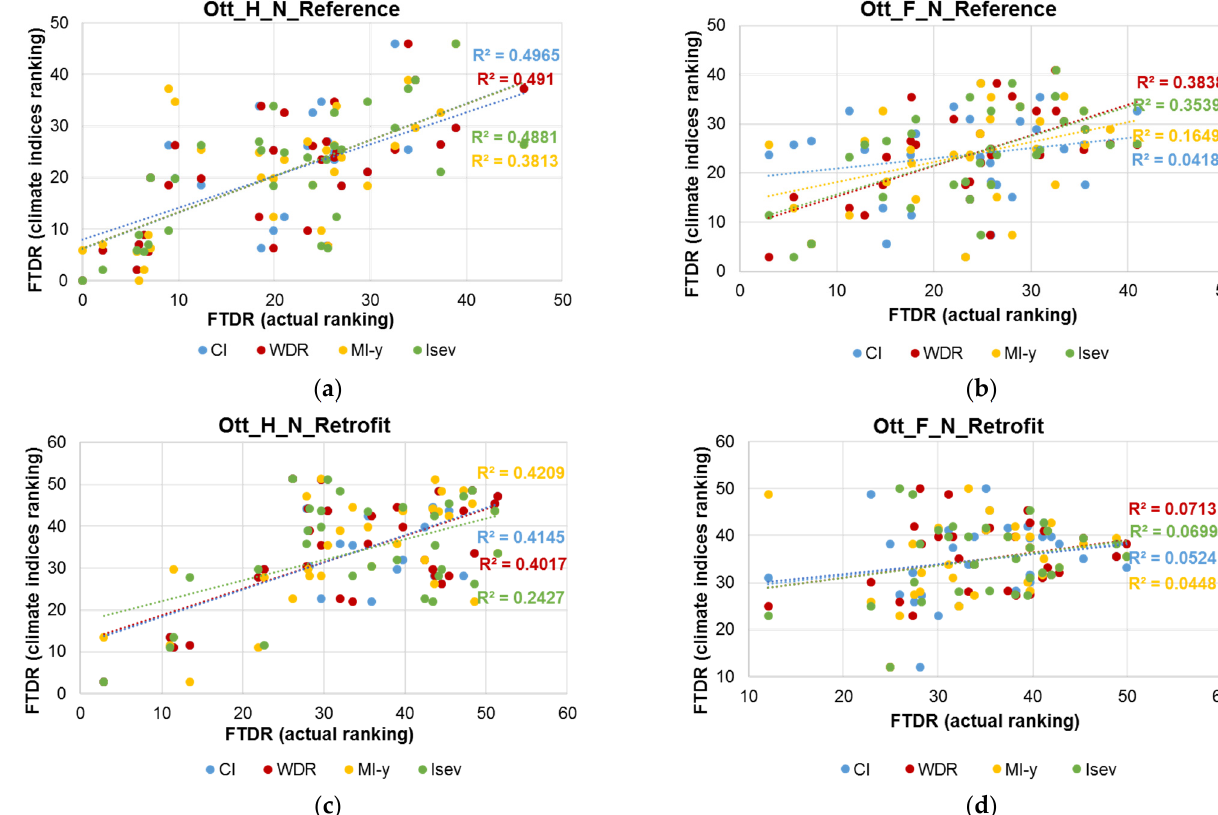
Figure 5. Correlation between FTDR values based on the actual ranking and FTDR values based on the climatic indices ranking—for ( a ) a reference wall under historical period, ( b ) a reference wall under future period, ( c ) a retrofit wall under historical period, and ( d ) a retrofit wall under future period, all facing North orientation in Ottawa. Table 4. The correlation coefficient (R 2 ) between response-based indices values based on their actual ranking, and their corresponding values based on climate-based indices ranking—for a North and WDR oriented reference wall and retrofit wall under historical and future periods in Ottawa. The highest values per index and climate are marked in bold.